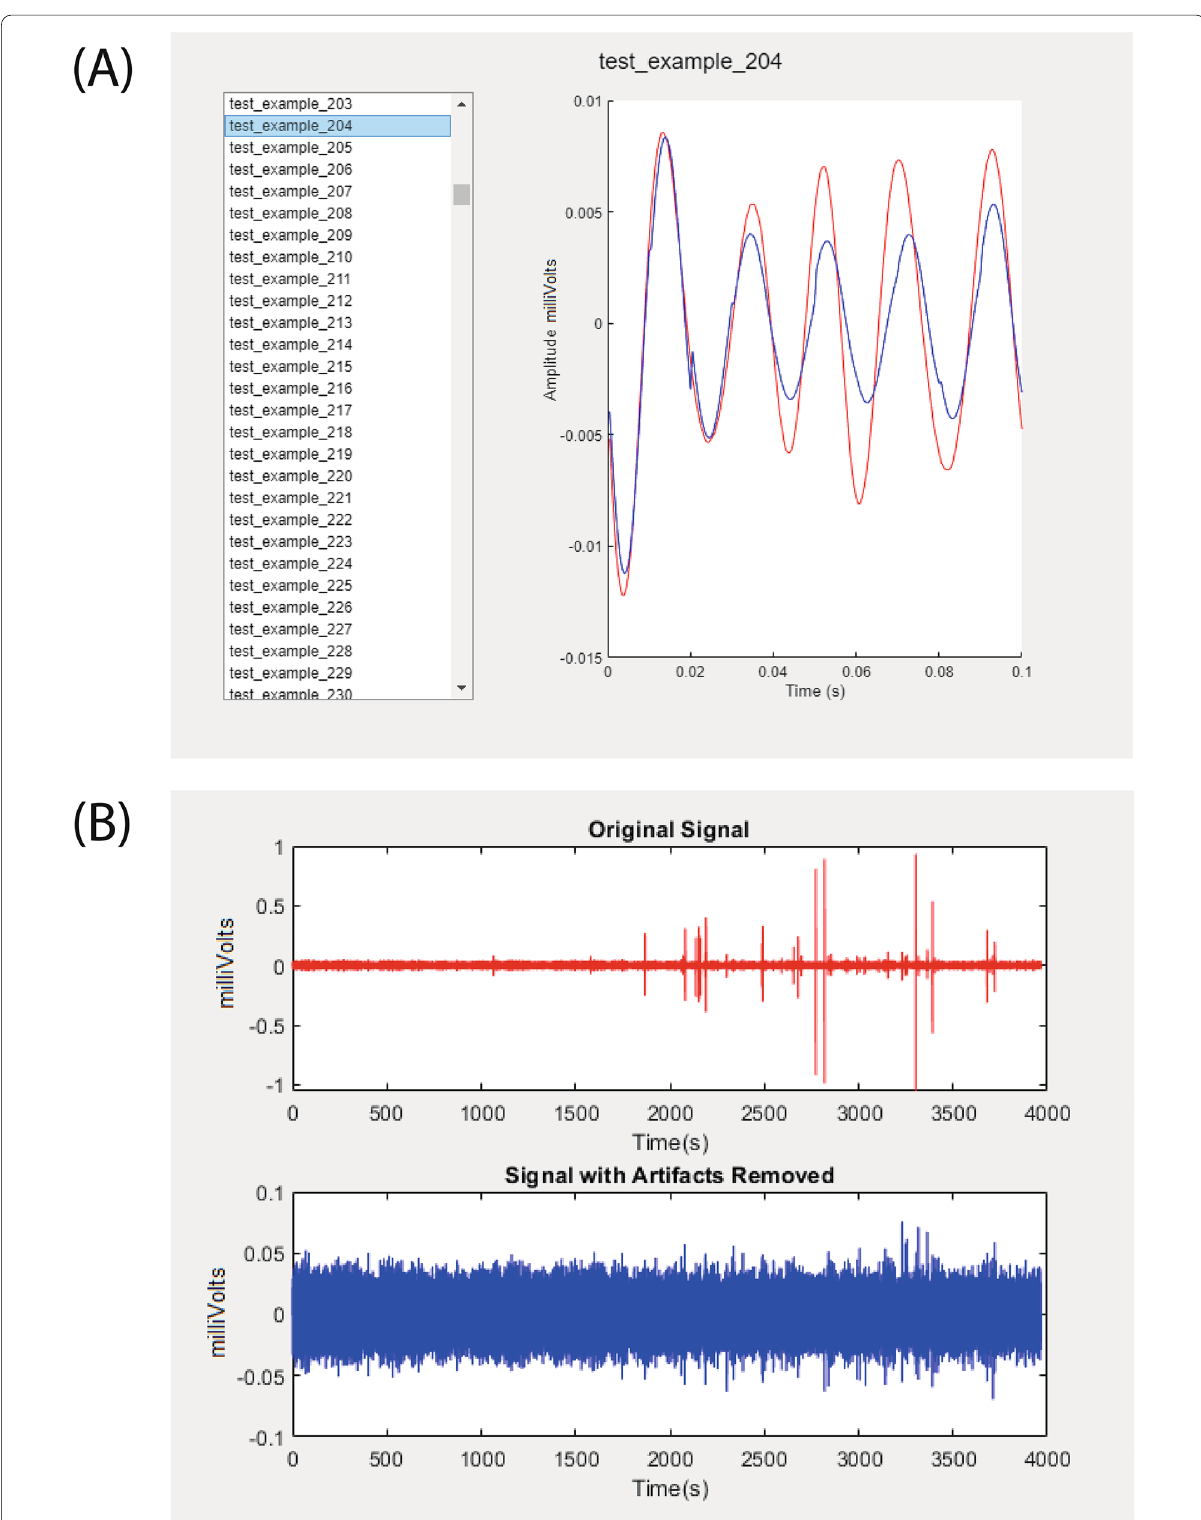
Fig. 4 Visualisation of the test set ( a ) and comparison of the original signal with artefacts removed ( b ) are the outputs of the artefact removal module. The original signal appears in red in both outputs, while the predicted or artefact-free signal appears in